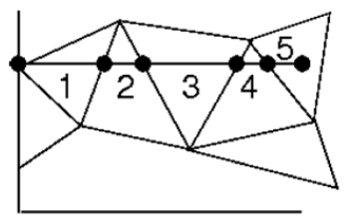
Figure 5. Dividing geotextiles on rod